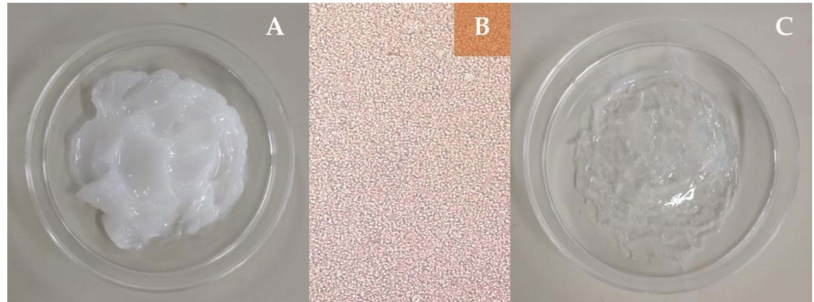
Figure 1. ( A ) Optical image of a typical G-series HIPE; ( B ) optical micrographs (40 × ) of HIPE in the presence of the Sudan Red G; and ( C ) optical image of G-series polyHIPE chemically crosslinked by glutaraldehyde.